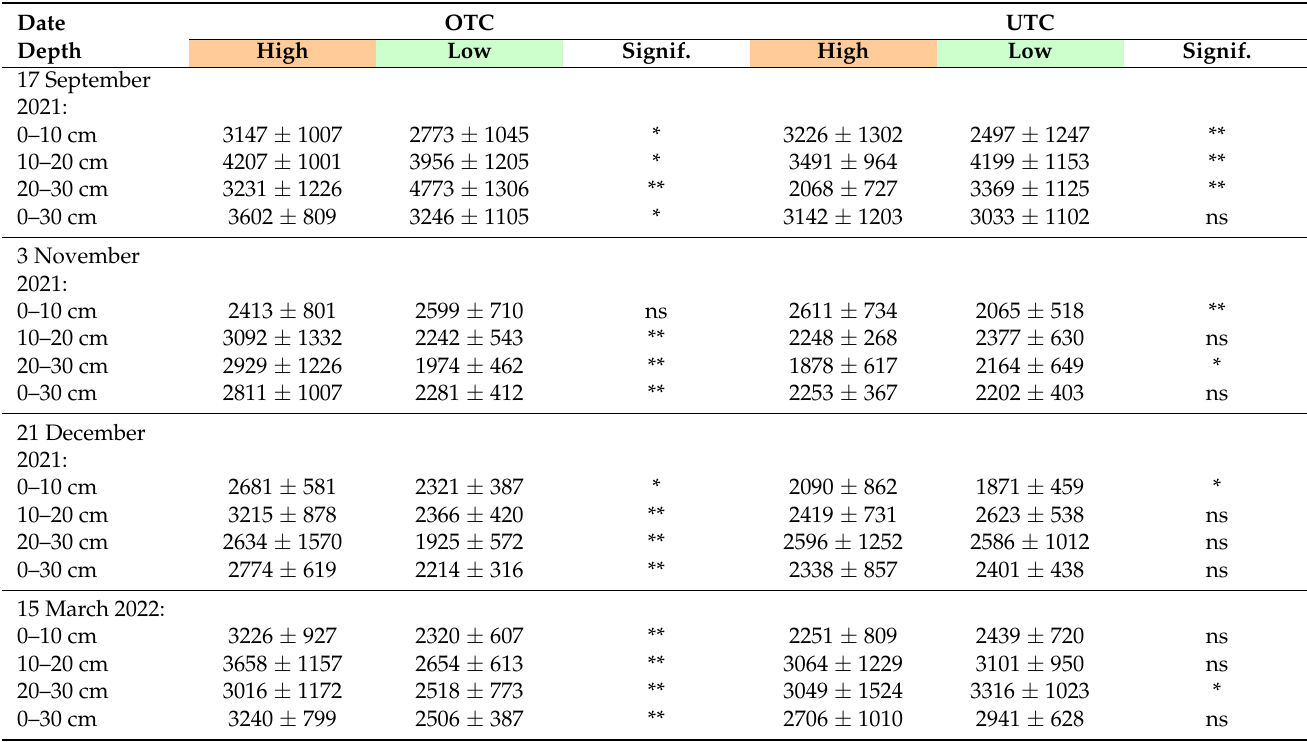
Table 6. Descriptive (mean ± standard deviation; kPa) and inferential analysis of Cone Index in “high” and “low” grazed areas, outside and under the tree canopy (OTC and UTC, respectively), on the four dates (2021/2022) at different soil